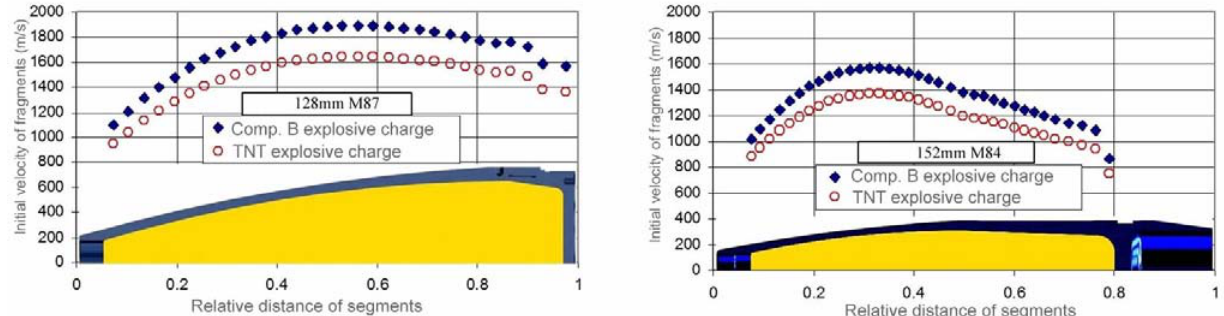
Figure 7. Variation of initial velocity of fragments, depending on the type of explosives (TNT and Composition B charge) for rocket projectile warhead - model 128mm HE M87 and artillery projectile - model 152mm HE M84